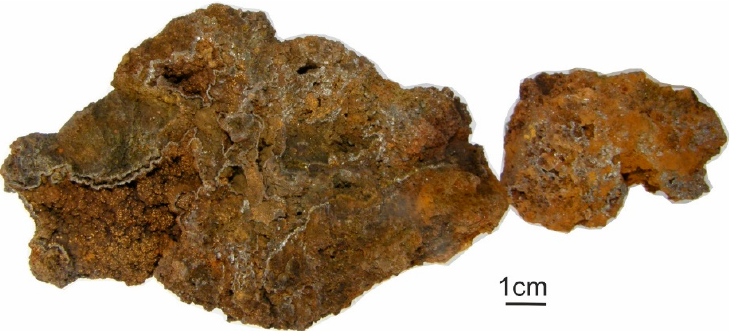
Figure 15. A general view of sulfide samples from st. 373. Porous massive sulfides oxidized from the surface.